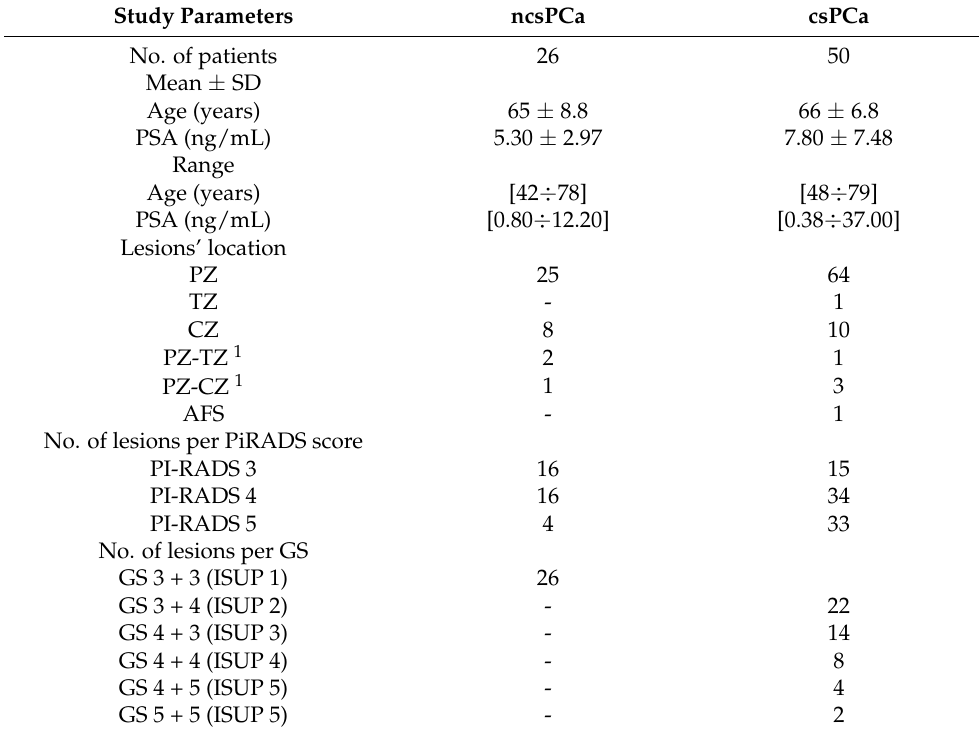
Table 1. Clinical parameters of the study population, including age, PSA level surveyed contextually to mpMRI, location of PCa lesions, PI-RADS score and GS.